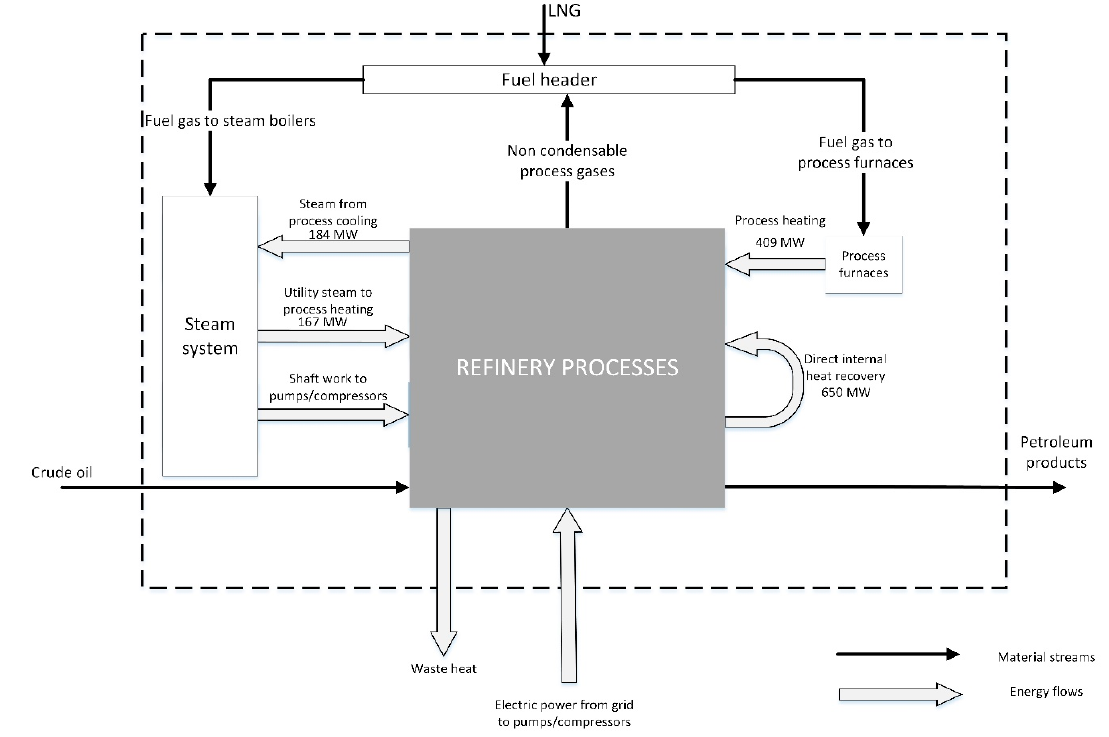
Figure 2. Major material and energy flows of the studied refinery. Data for shaft work from steam turbines and electricity to pumps/compressors was not collected at the same time as the process stream data. The refinery steam system is described in detail in reference [36].